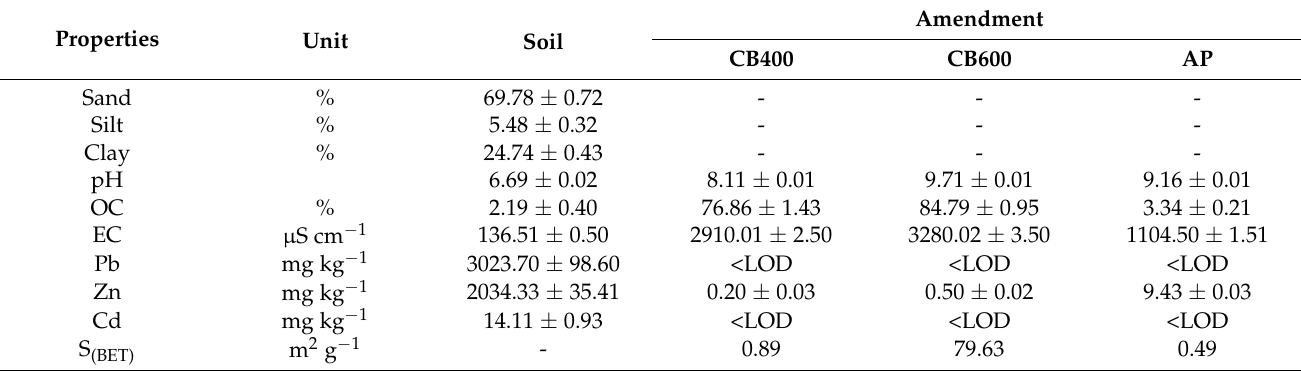
Table 1. Physicochemical properties of the soil and amendments